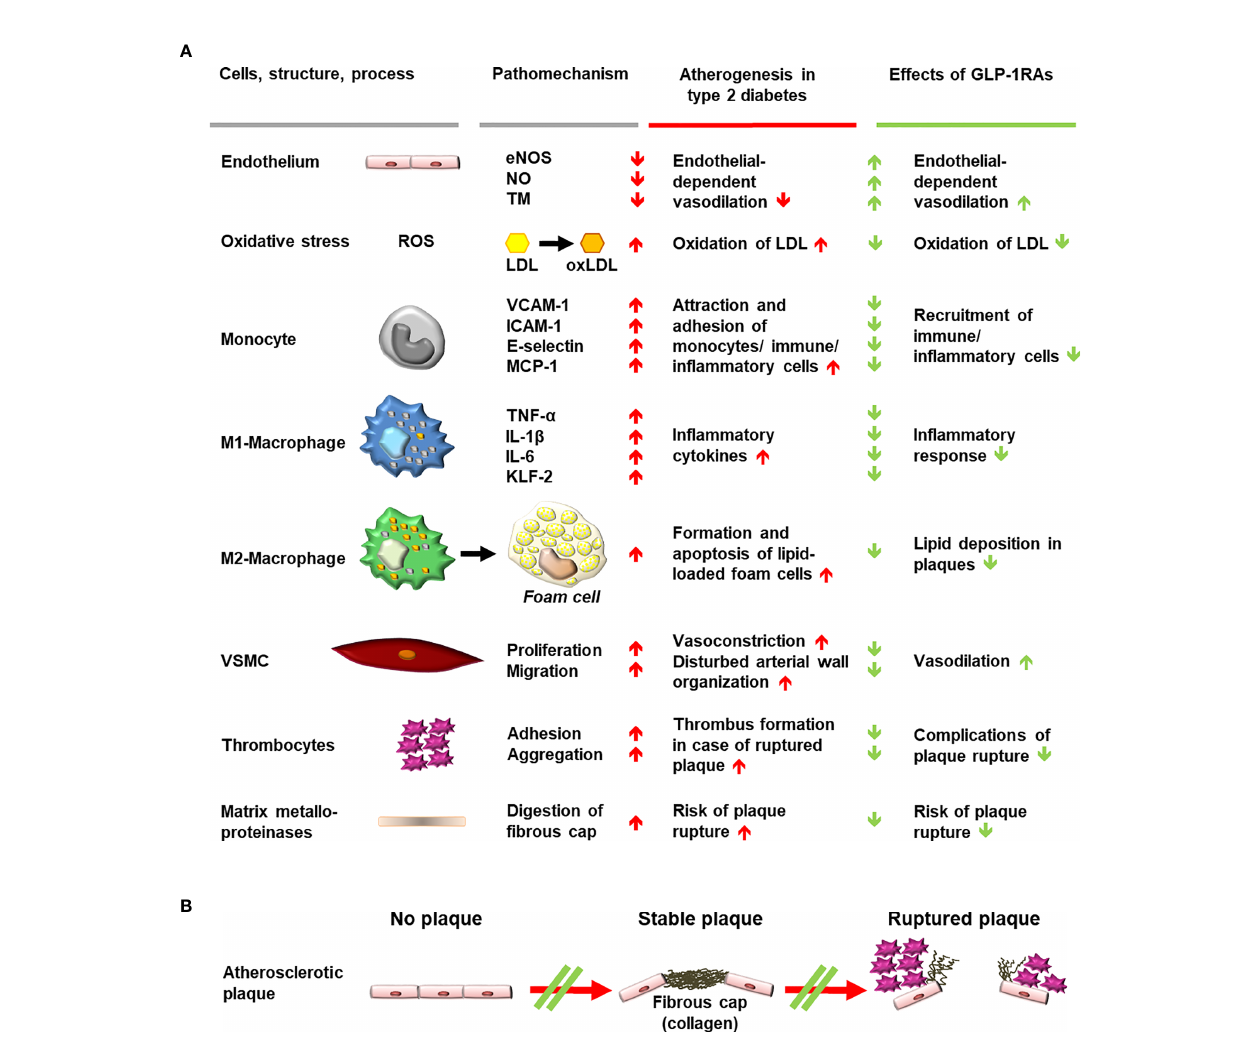
FIGURE 3 | Schematic diagram of mechanisms involved in generating atherosclerotic lesions in patients with type 2 diabetes and anti-atherosclerotic effects of stimulating GLP-1 receptors with GLP-1RAs. (A) Cells, structures, and processes involved in atherogenesis, for which evidence suggests an interference of GLP-1 receptor stimulation with pro-atherogenic mechanisms. Findings worsening the progression of atherogenesis are depicted as red arrows, while bene fi cial effects of GLP-1RAs on pathomechanisms and atherogenesis are shown as green arrows. (B) Progression of plaque formation towards an increased likelihood of rupture is shown with red arrows. Interference with the formation of plaques or with progression towards plaque rupture is shown as a green double line crossing a red arrow. eNOS, endothelial nitrous oxide synthase; GLP-1, glucagon-like peptide-1; GLP-1RA, glucagon-like peptide-1 receptor agonist; ICAM-1, intercellular adhesion molecule 1; IL, interleukin; KLF-2, Krüppel-like factor 2; LDL, low-density lipoprotein; MCP-1, monocyte chemoattractant protein 1; NO, nitrous oxide; oxLDL, oxidized low-density lipoprotein; ROS, reactive oxygen species; TM, thrombomodulin; TNF- a , tumor necrosis factor alpha; VCAM-1, vascular cell adhesion protein 1; VSMC, vascular smooth muscle